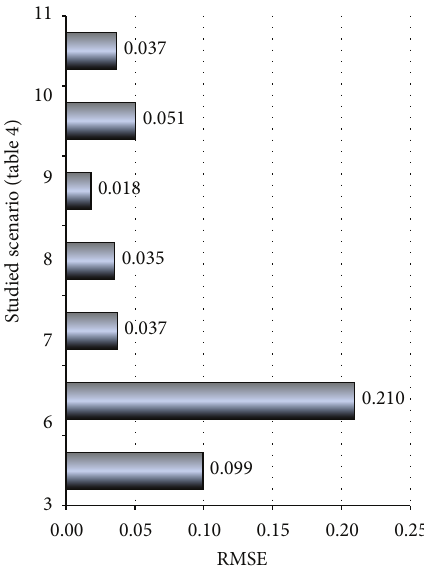
Figure 9: RMSE values of the studied